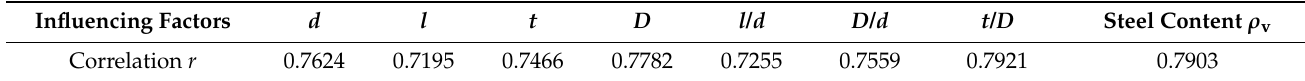
Table 5. Correlation of each factor with the bonding